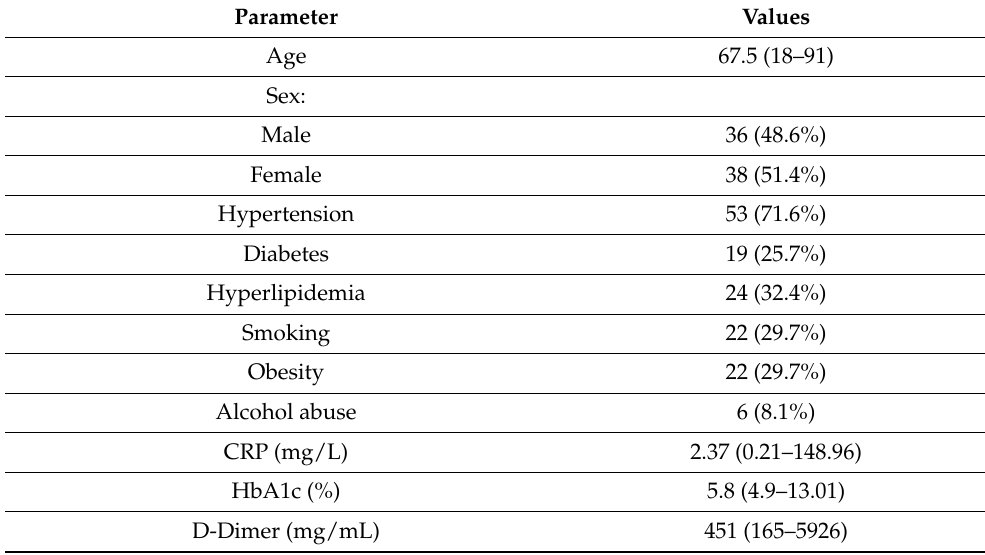
Table 1. The general characteristics of ischemic stroke subjects ( n =